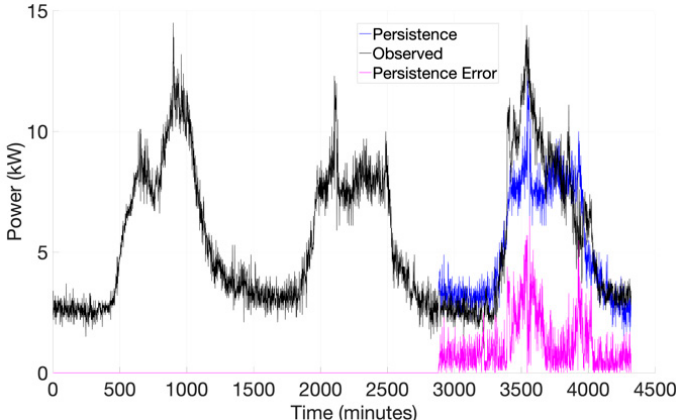
Figure 10. Persistence applied in home 1 forecasting.